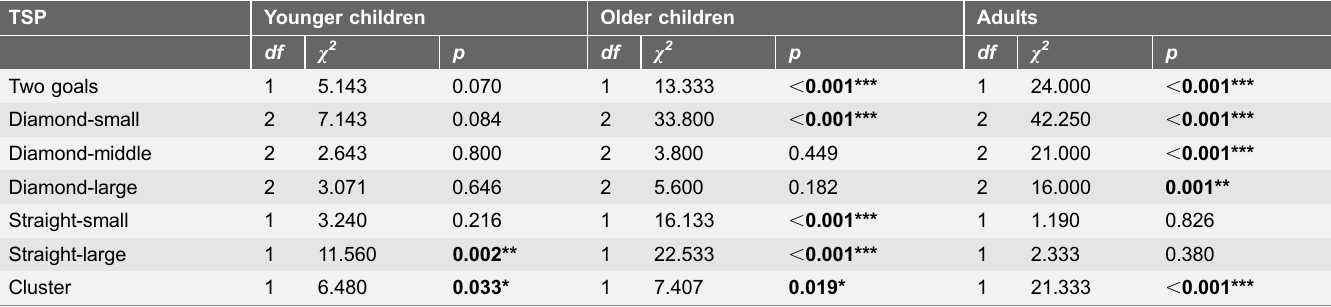
Table 4. Results of chi-square goodness-of-fit tests regarding number of trials with selection of each route.